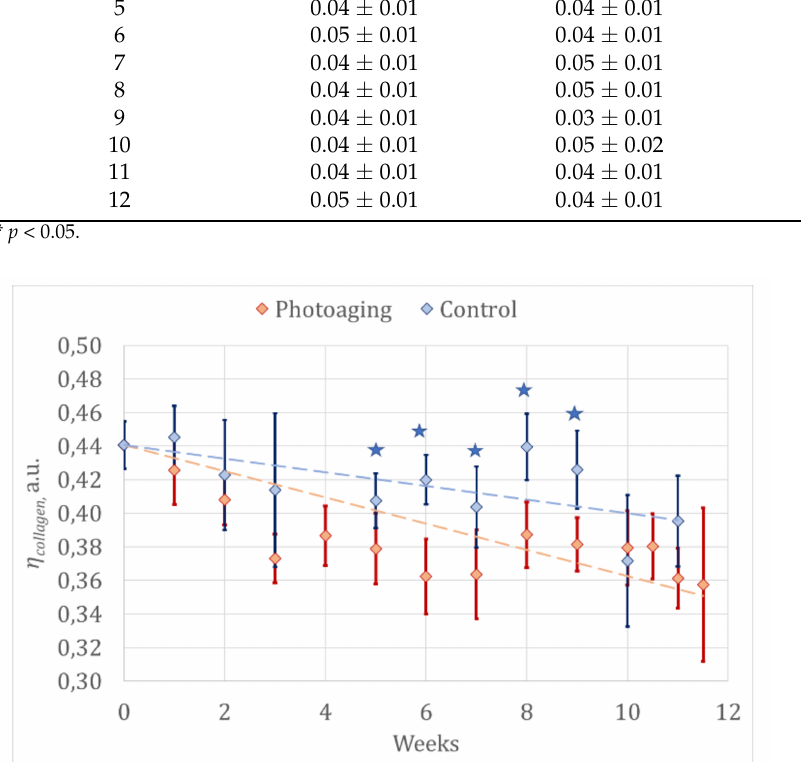
Figure 3. The dynamic of mean values of tissue content indices of collagen η collagen in animals from the control group and the photoaging group; 95% confidence intervals are specified. Asterisks indicate significant differences between the groups according to the Mann–Whitney test ( p <